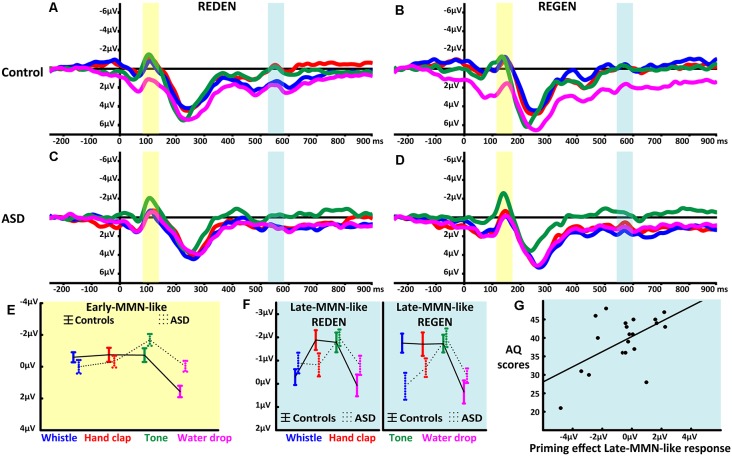
Mismatch negativity (MMN)-like responses to spoken words in context of different sounds. (A,B) Event-related potentials elicited by the two critical words in the four context conditions (whistle context in blue, hand clap in red, pure tone in green and water drop in magenta) recorded at fronto-central electrodes (average of F3, F1, Fz, F2, F4, FC3, FC1, FCz, FC2, FC4) in TD participants. (C,D) Event-related potentials elicited by the two critical words in the four context conditions (whistle context in blue, hand clap in red, pure tone in green and water drop in magenta) recorded at fronto-central electrodes (average of F3, F1, Fz, F2, F4, FC3, FC1, FCz, FC2, FC4) in the ASD participants. The ERPs on the left (A,C), show the MMN-like responses to “REDEN” (re:dn) while the ERPs on the right (B,D), those to “REGEN” (re:gn) with their respective early- and late-MMN-like time windows highlighted (i.e., early-MMN-like in light yellow, and the late-MMN-like in light blue). (E) Statistically significant interaction of Context and Group (means and SEM) in the early-MMN-like (i.e., before word recognition point, see Supplementary Information) time latency. (F) The statistically significant interaction of Word, Sound, Group (means and SEM) for the late-MMN-like component (i.e., after word recognition point, see Supplementary Information). (G) The significant correlation, observed in ASD participants, between the neurophysiological index of semantic priming and the number of autistic traits, assessed by the autism-spectrum quotient (AQ; r = 0.5461, p = 0.013).